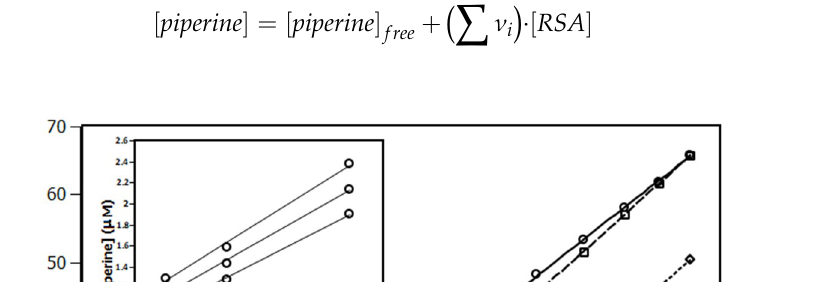
Figure 6. Scatchard plot of RSA and piperine at 288 K based on the interaction density function (IDF) model.